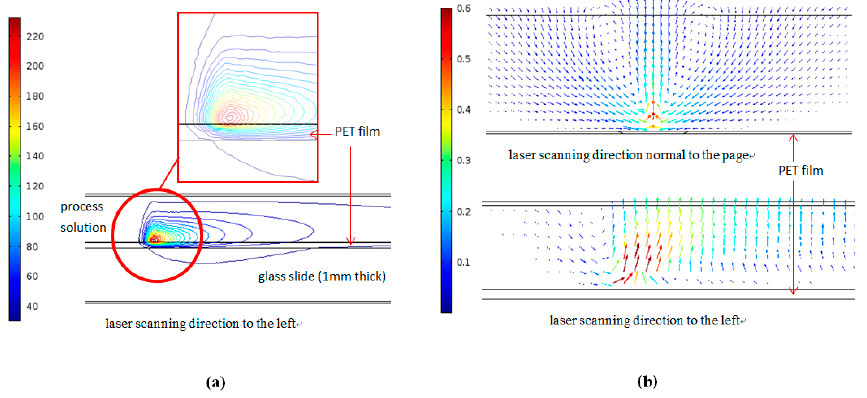
Figure 10. ( a ) Temperature (unit: °C) profile; and ( b ) velocity (unit: mm/s) profile near the laser focal point.